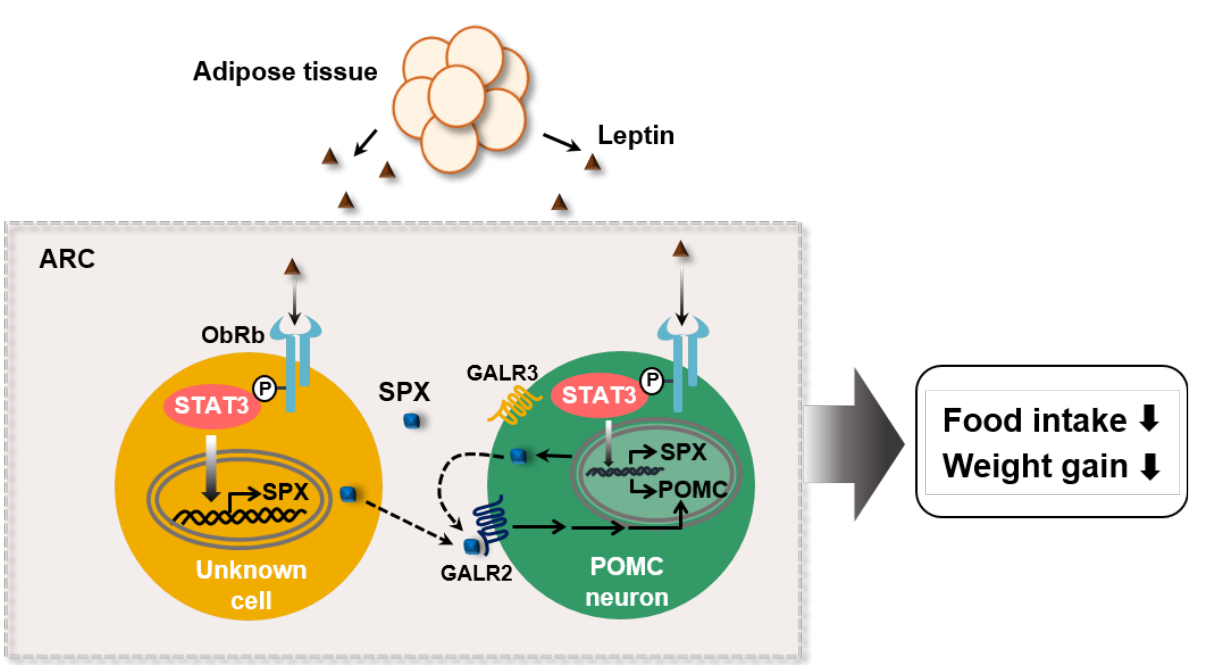
Figure 6. Proposed model for SPX action in leptin-mediated control of food intake within the hypothalamic ARC. SPX is synthesized under a control of leptin in the ObRb expressing cells and acts on POMC expression via GALR2 receptor signaling. Dashed lines represent autocrine and/or paracrine SPX action.